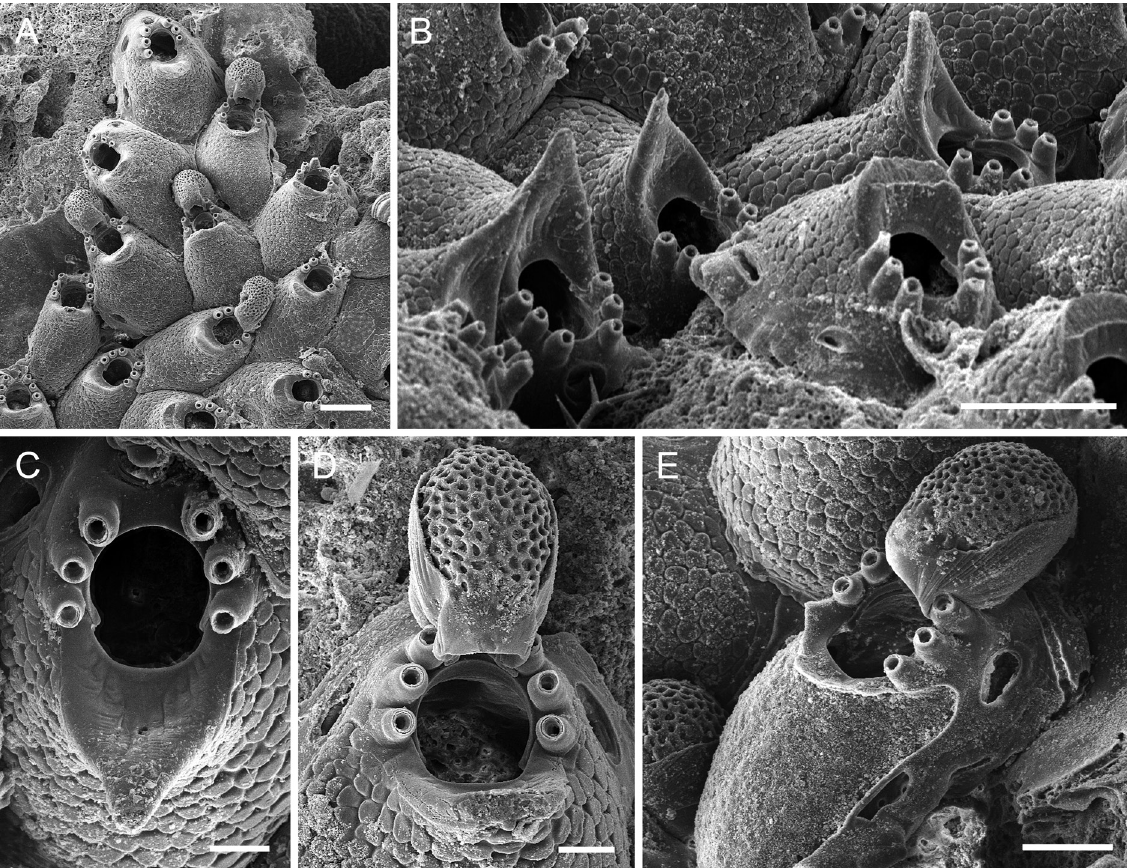
Fig. 5. Atlantisina seinensis gen. et sp. nov., Seine Smt, holotype (MNHN-IB-2014-57). A . Autozooids and ovicellate zooids. B . Lateral view showing the vertical dimensions of the suboral umbones. C . Orifice. D . Ooecium. E . Early ontogenetic zooid with a fully formed ooecium. Scale bars: A–B = 200 µm; C–D = 50 µm; E = 100 µm.